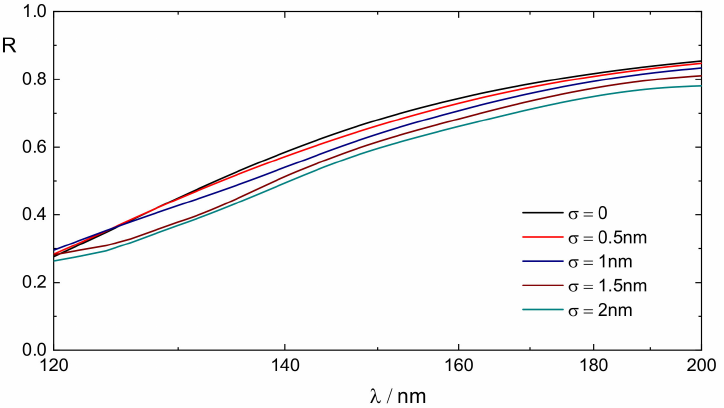
Figure 8. Calculated VUV reflectance of unprotected aluminum films with Λ = 56 nm and different rms roughnesses σ .